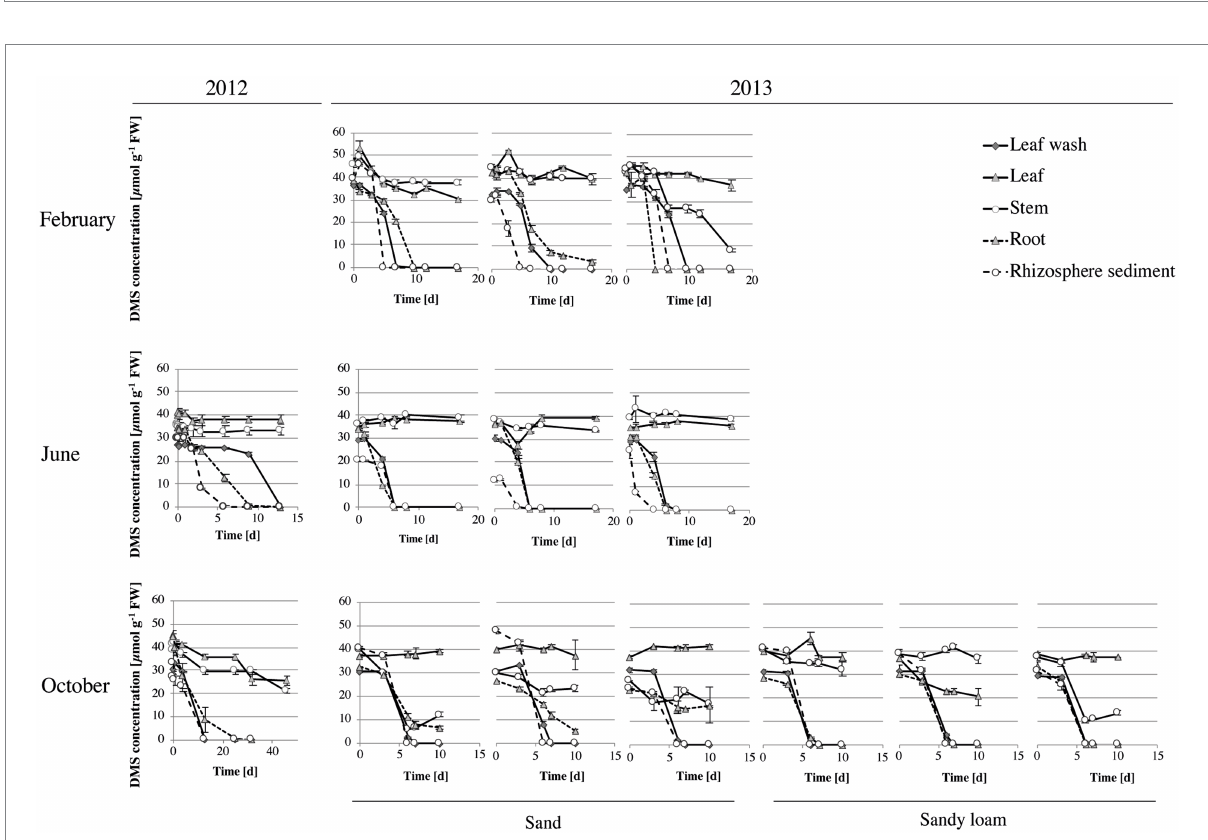
FIGURE 3 DMS degradation in Sporobolus anglicus tissue samples. Determination of DMS concentration was carried out with fresh leaf wash, leaf, stem, root and rhizosphere sediment samples from S. anglicus from June, October 2012 and February, June and October 2013. Experiments in June and